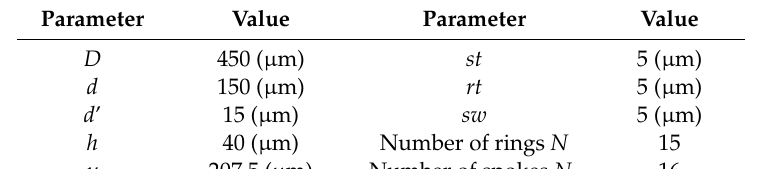
Table 2. Key design parameters of disc sensitive structure of MOEMS.